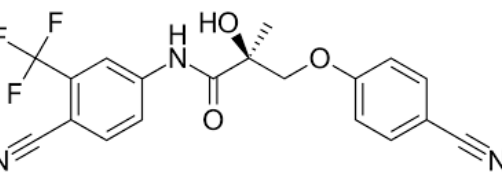
Figure 32. Chemical structure of ostarine. Formula: C 19 H 14 F 3 N 3 O 3.